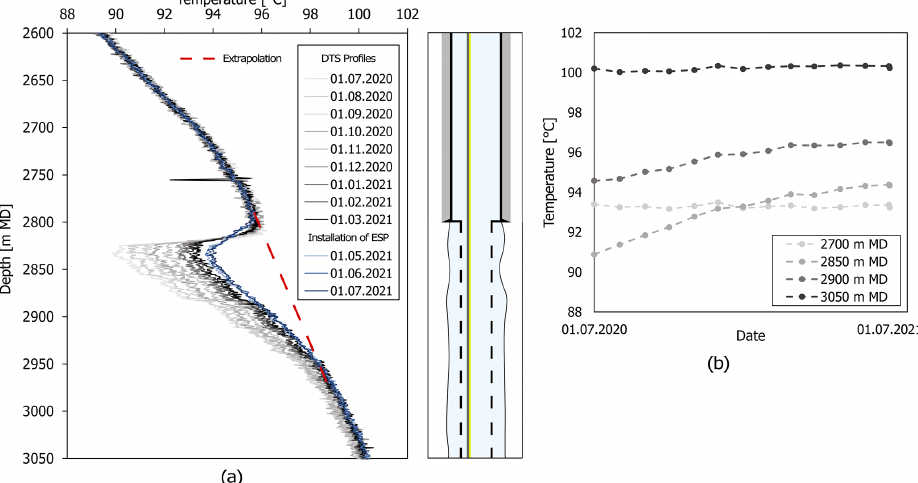
Figure 3. (a) DTS profiles between July 2020 and July 2021 and a schematic of the wellbore with sketched fiber-optic cable (yellow line) clamped to sucker rod (grey line) and (b) temperatures at different depths plotted versus time. The grey DTS profiles in (a) are from the shut-in period before the ESP was installed and the blue DTS profiles were measured after installation. The displayed DTS data are averaged over 6h at a spatial resolution of 1m. The temperature anomaly below 2750m in (a) is a measuring fragment due to the inline splice from the downhole P/T